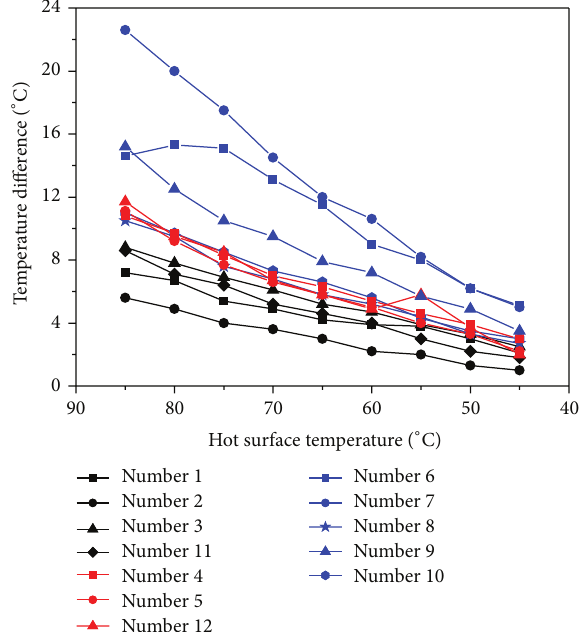
Figure 5: Temperature difference as a function of hot surface temperature for the paper